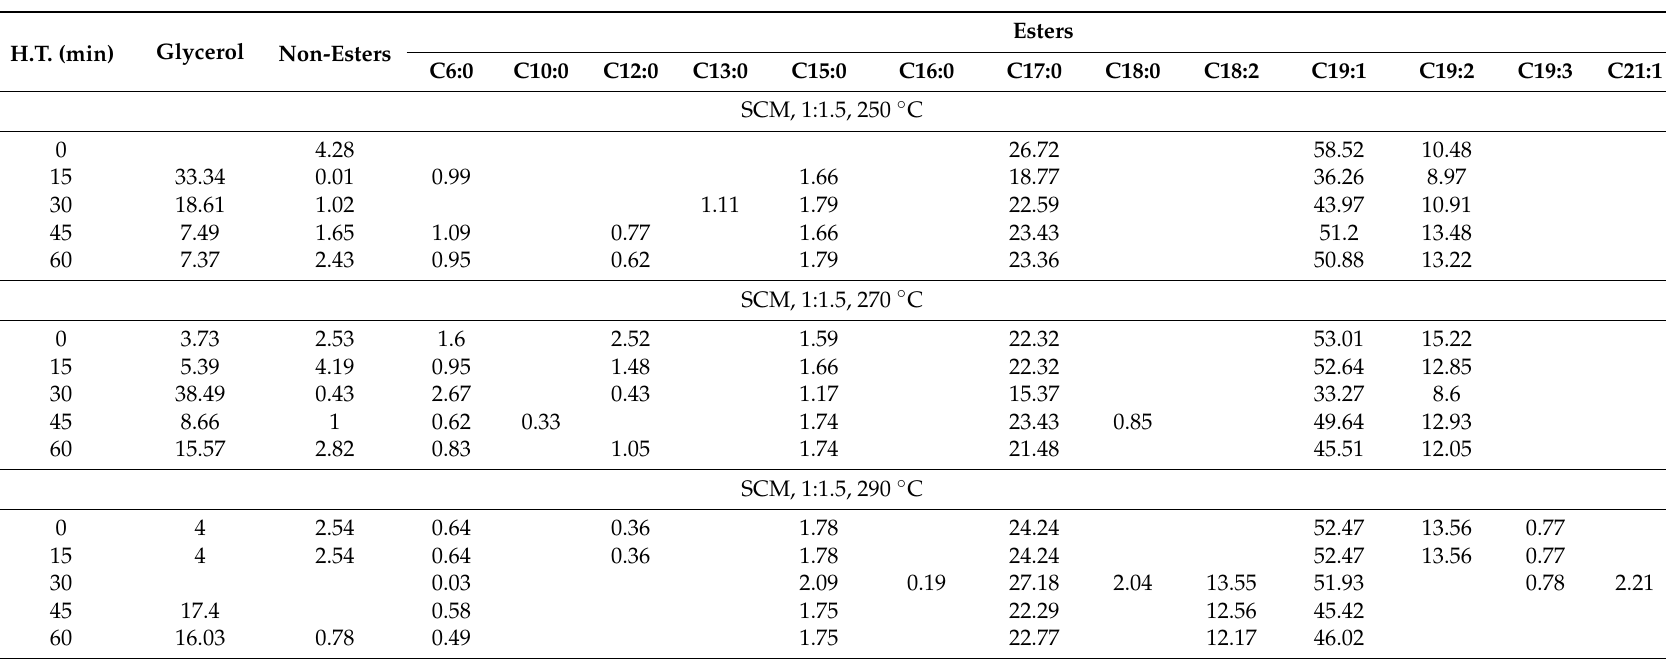
Table 3. The weight percentage of compounds according to the carbon number of liquid products obtained at different transesterification temperature for different holding times for waste pig fat to methanol ratio of